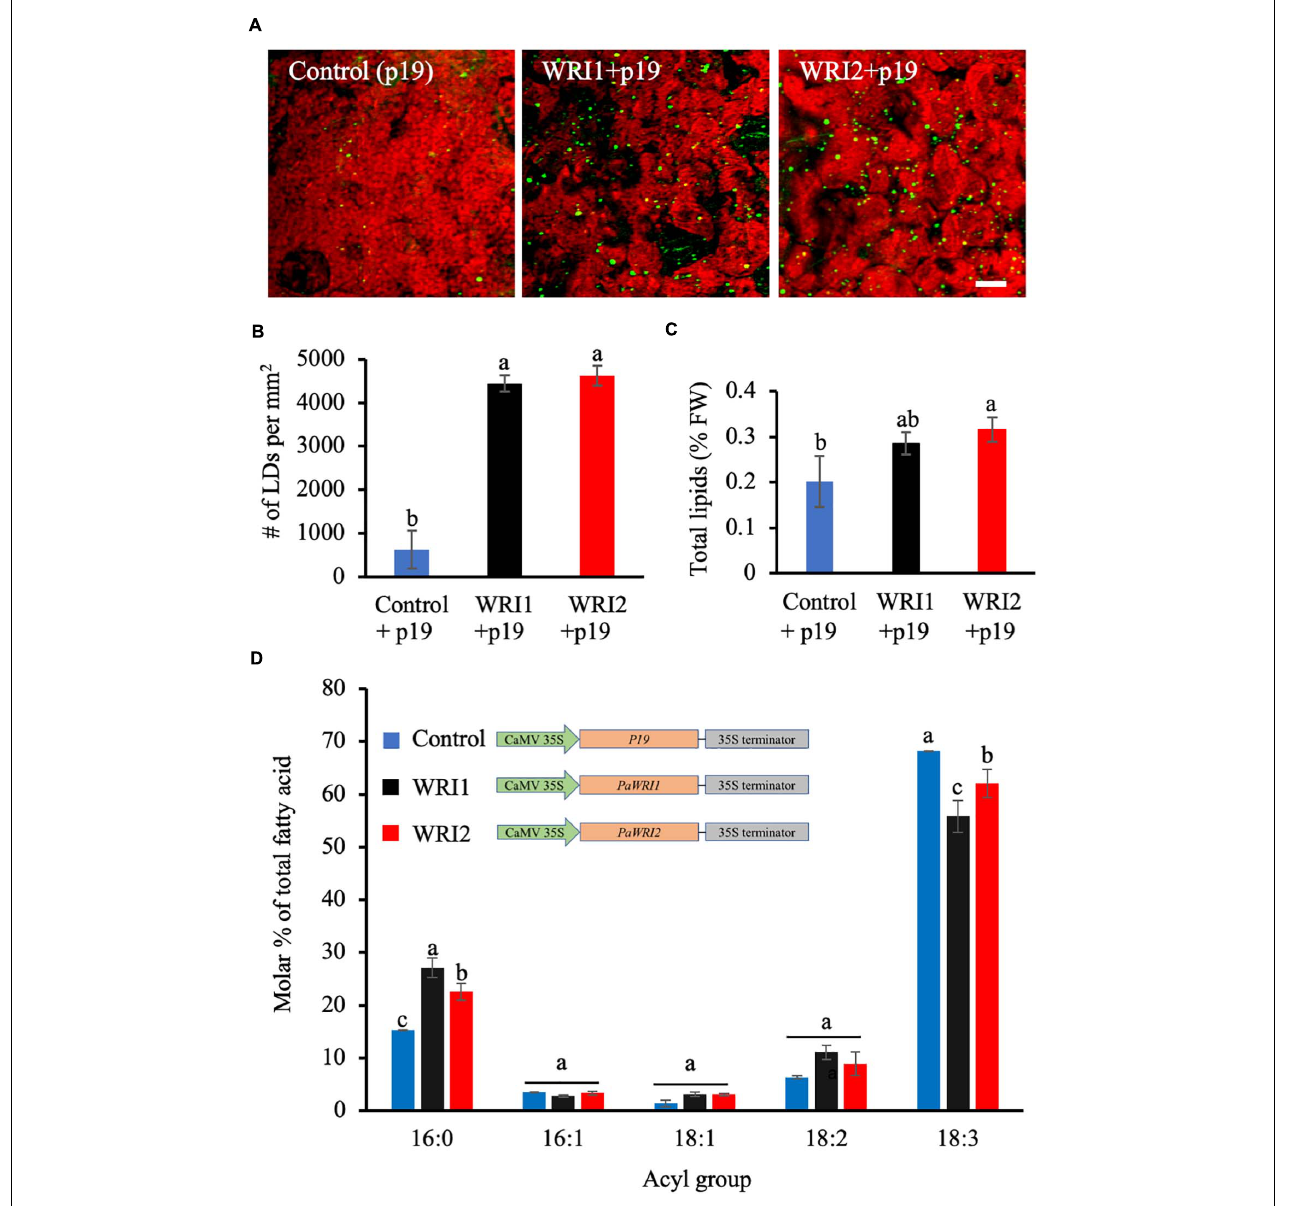
FIGURE 5 | Lipid content and fatty acid composition of N. benthamiana leaves expressing PaWRI1 and PaWRI2 . (A) Confocal images of accumulated lipid droplets (LDs) stained with Nile Red (green) in N. benthamiana leaves infected with Agrobacterium expressing control ( p19 alone), PaWRI1 ( +p19 ), and PaWRI2 (+ p19) constructs. Scale bar corresponds to 20 µ m. (B) Quantification of accumulated LDs per unit surface area of the leaf tissue. (C) Quantification of total lipid (TL) content. (D) fatty acid profile of total lipids extracted from the infiltrated leaves. Data represent mean ± sd ( n = 3; p <